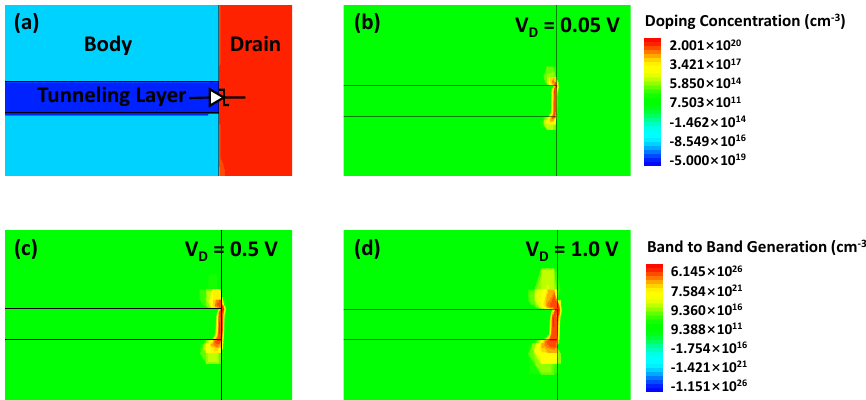
Figure 3. ( a ) The schematic diagram of tunneling layer and doping concentration in case of TNMOS. The band-to-band tunneling generation rate at tunnel junction with respect to drain voltage. The drain voltages are ( b ) 0.05, ( c ) 0.5, and ( d ) 1.0 V, respectively. The band-to-band tunneling generation rate becomes larger with the higher drain voltage.